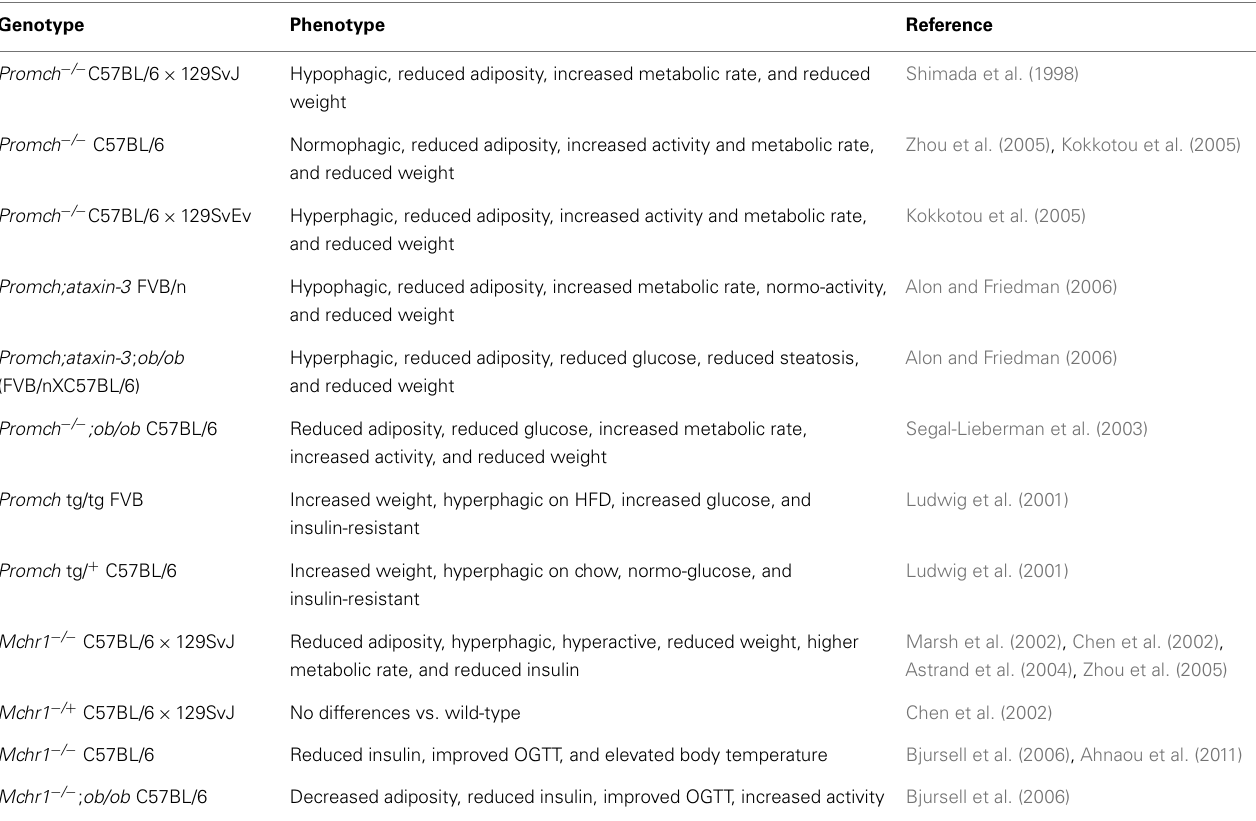
Table 1 | Mouse genetic models supporting a role for MCH in energy